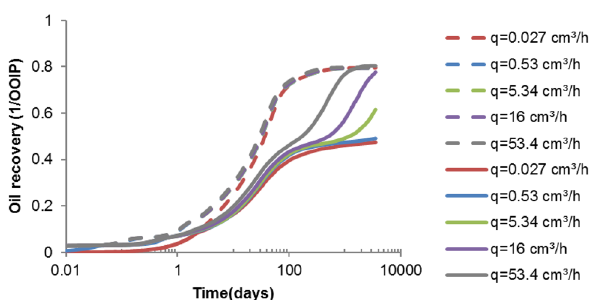
Fig. 12 Comparison of oil recovery versus time curves of the base case (with surfactant diffusion) and the contrastive case (without sur- factant diffusion). Dashed curves are oil recovery with surfactant dif- fusion; solid curves are oil recovery without surfactant diffusion